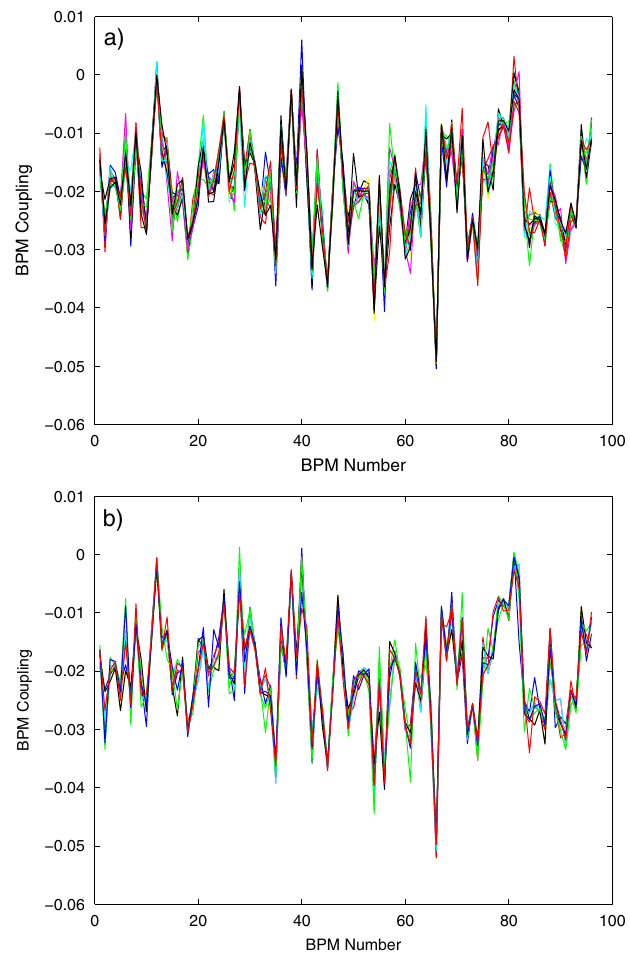
FIG. 3. Plots of LOCO fitted BPM vertical coupling. Plot (a) shows the results over several fits of varying machine condition, Plot (b) shows the results for multiple fits to the same machine